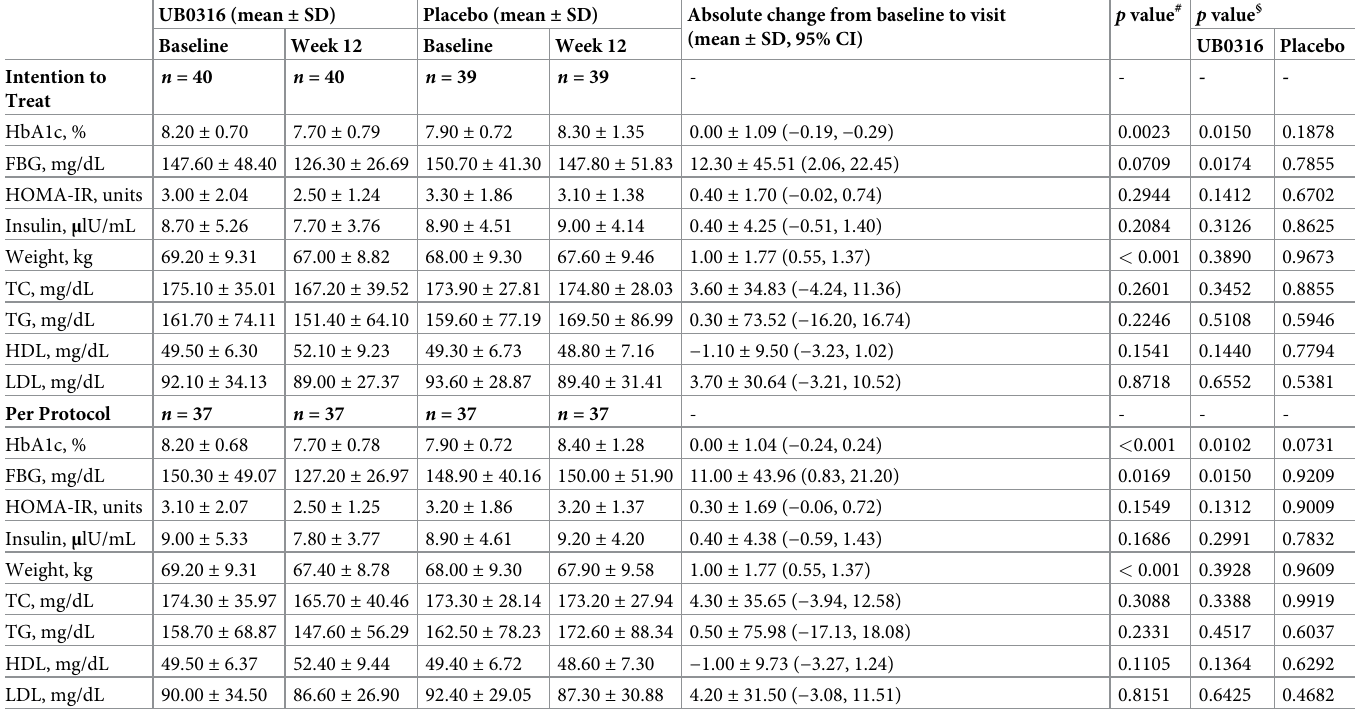
Table 2. Primary and secondary outcomes (baseline to week 12) of the Intention-to-Treat and Per Protocol